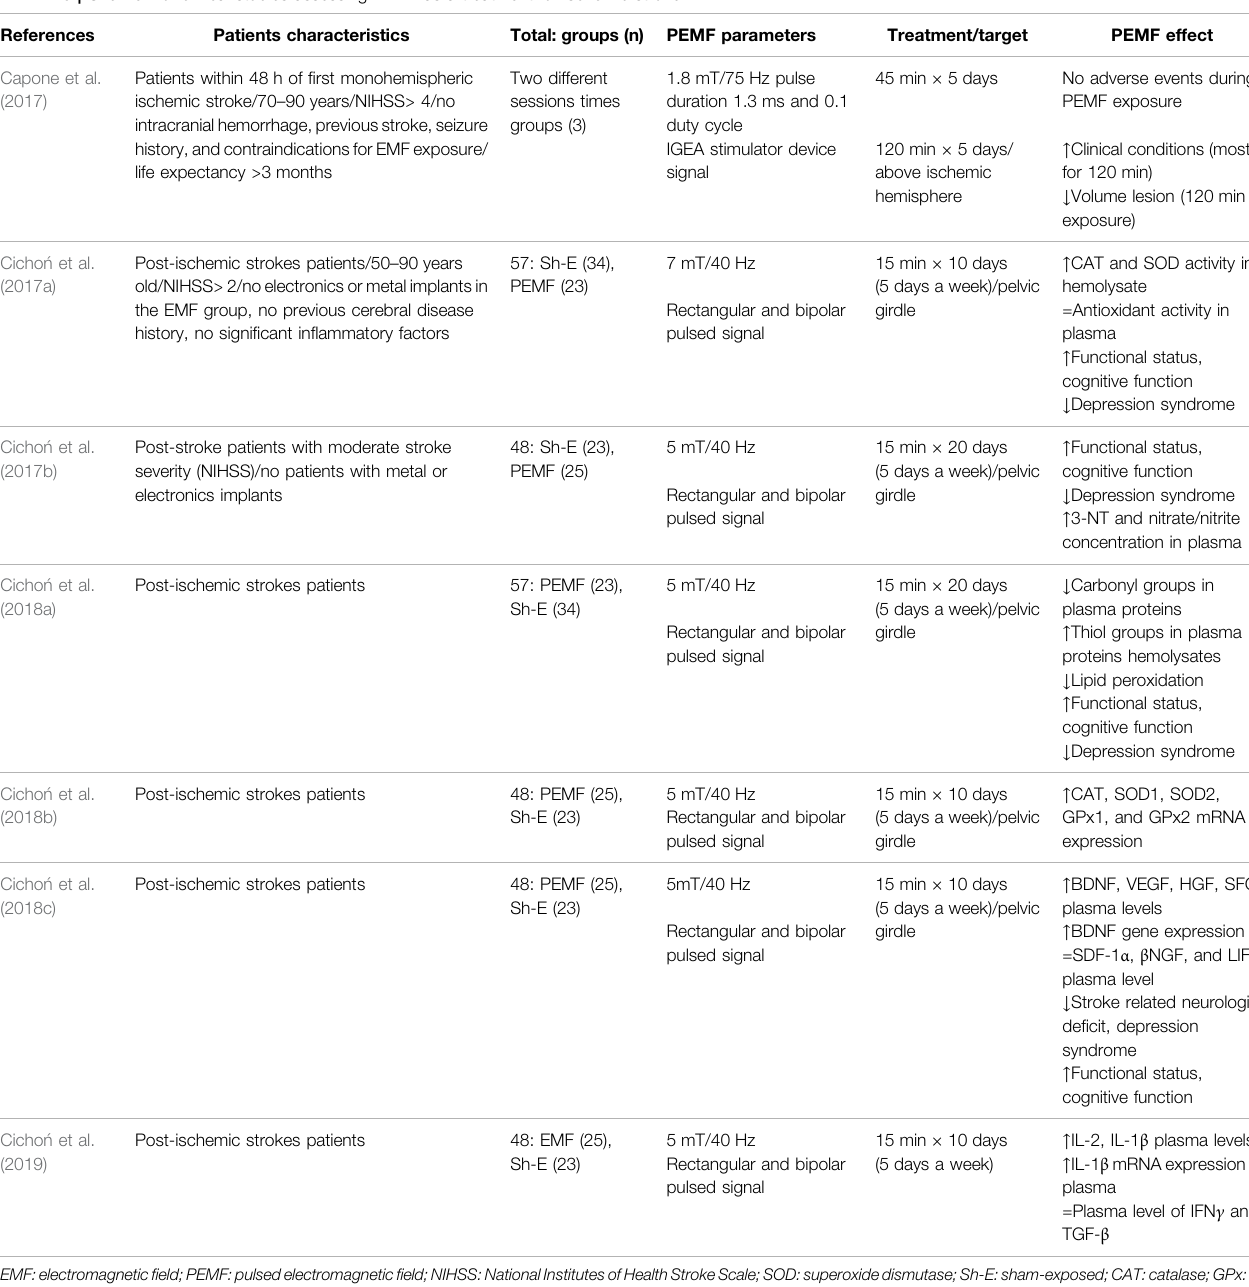
TABLE 6 | Overview of clinical studies assessing PEMF as a treatment for ischemic